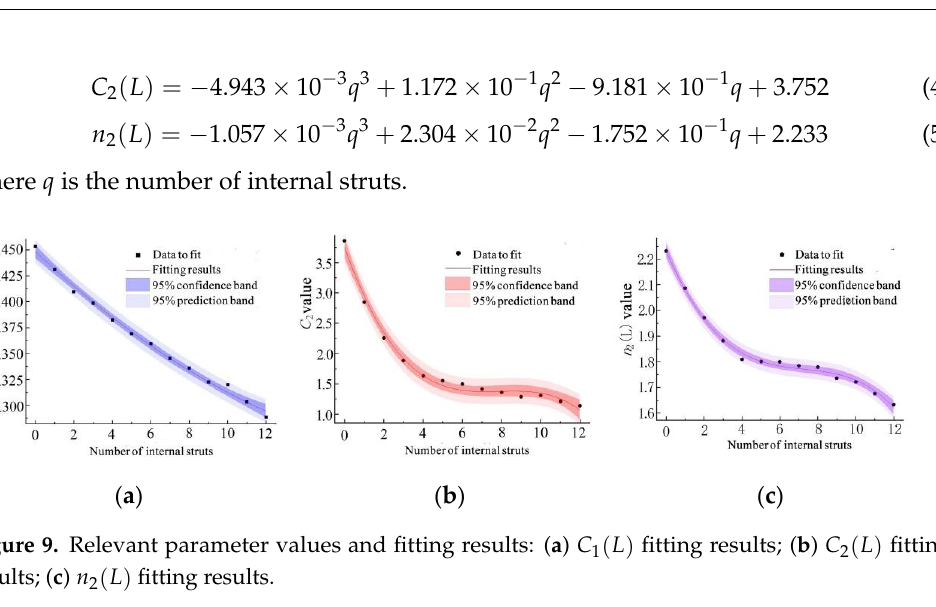
Table 4. Correlation coefficient values of fitting terms.